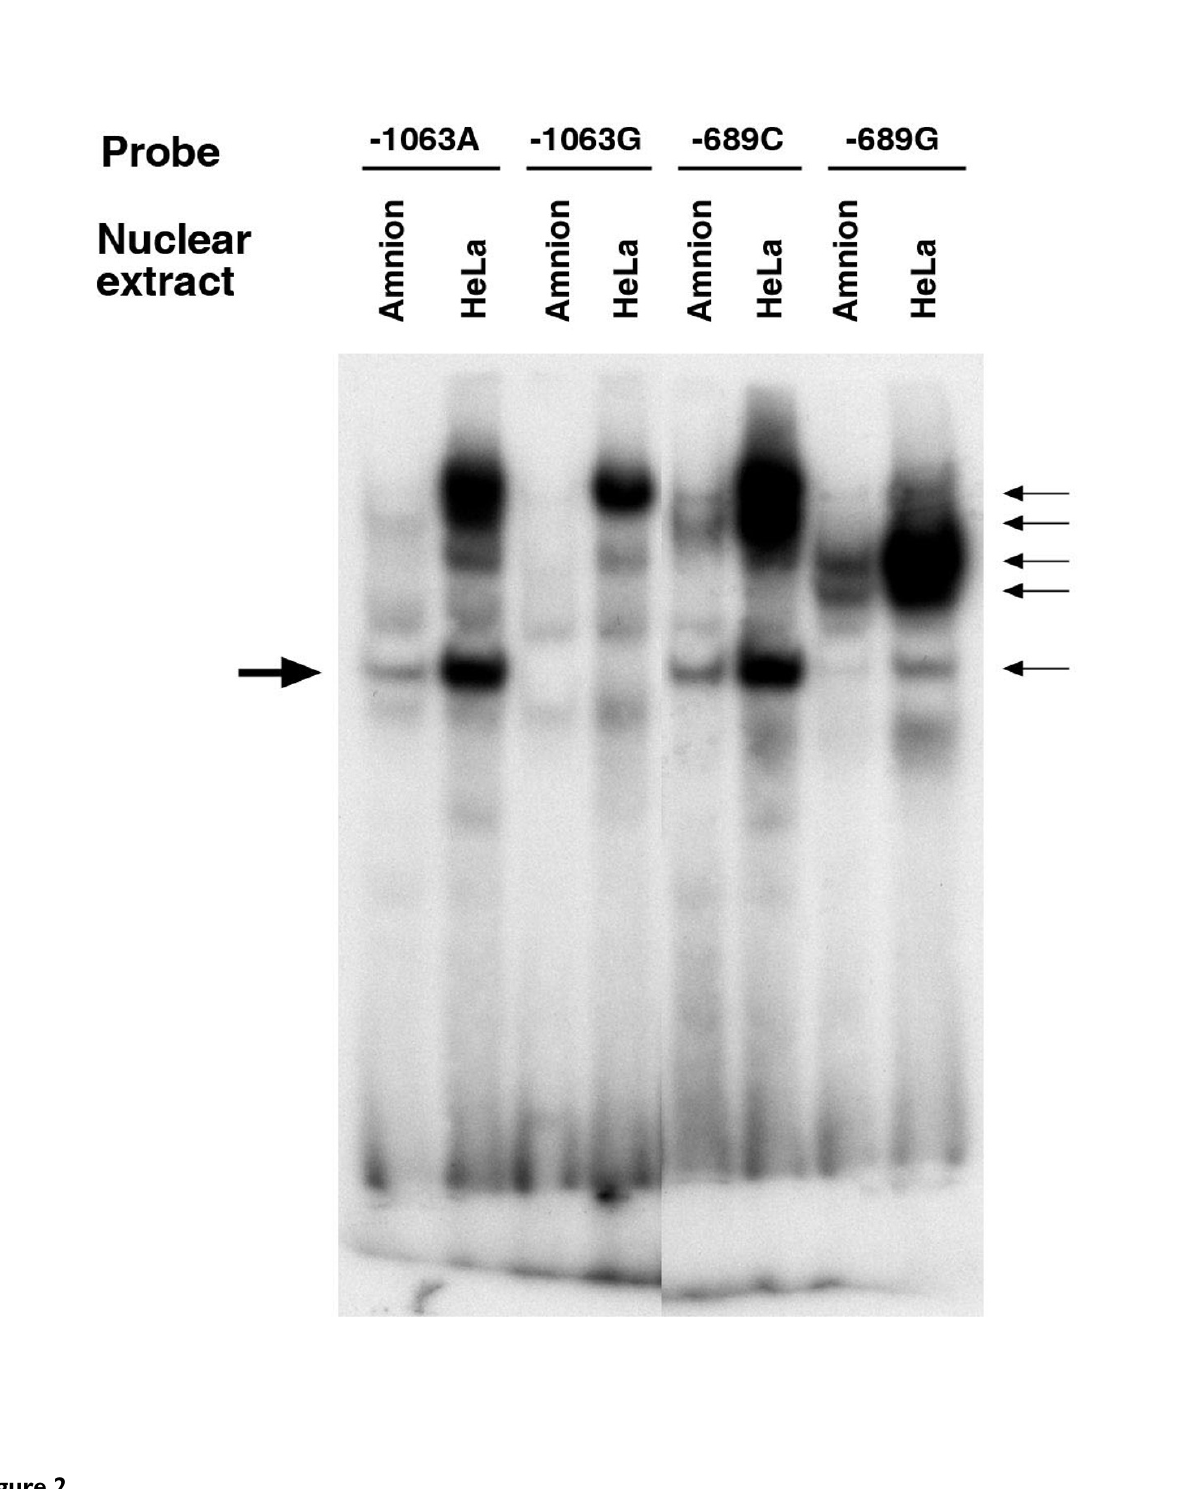
Figure 2 EMSA showing the banding patterns with HeLa and amniotic cell nuclear extracts for -1063A>G and -689C>G sites. The arrows indicate protein-DNA complexes formed when transcription factors bind to their target